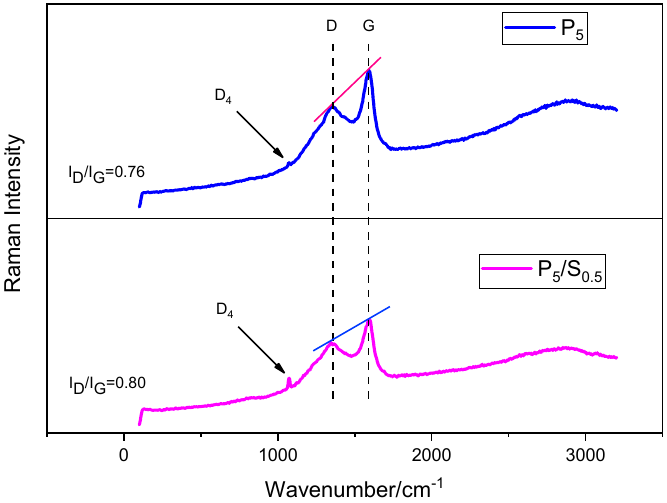
Figure 5. Raman spectra of char residues of P 5 and P 5 /S 0.5.